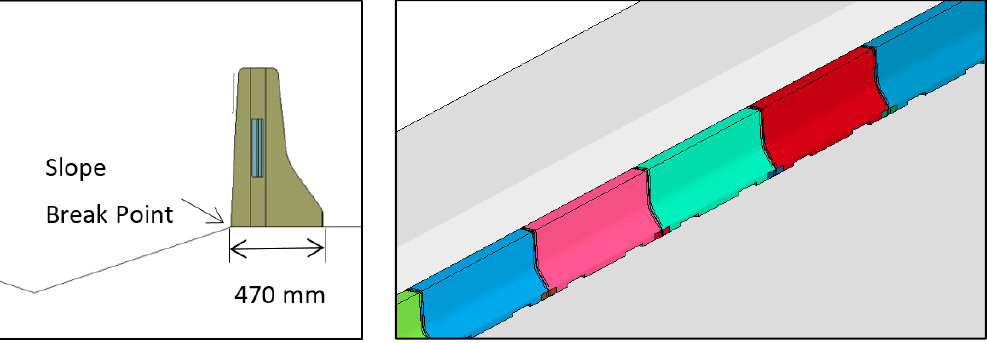
Figure 7. Finite element model of a concrete barrier installed at a slope break point of a ditch.